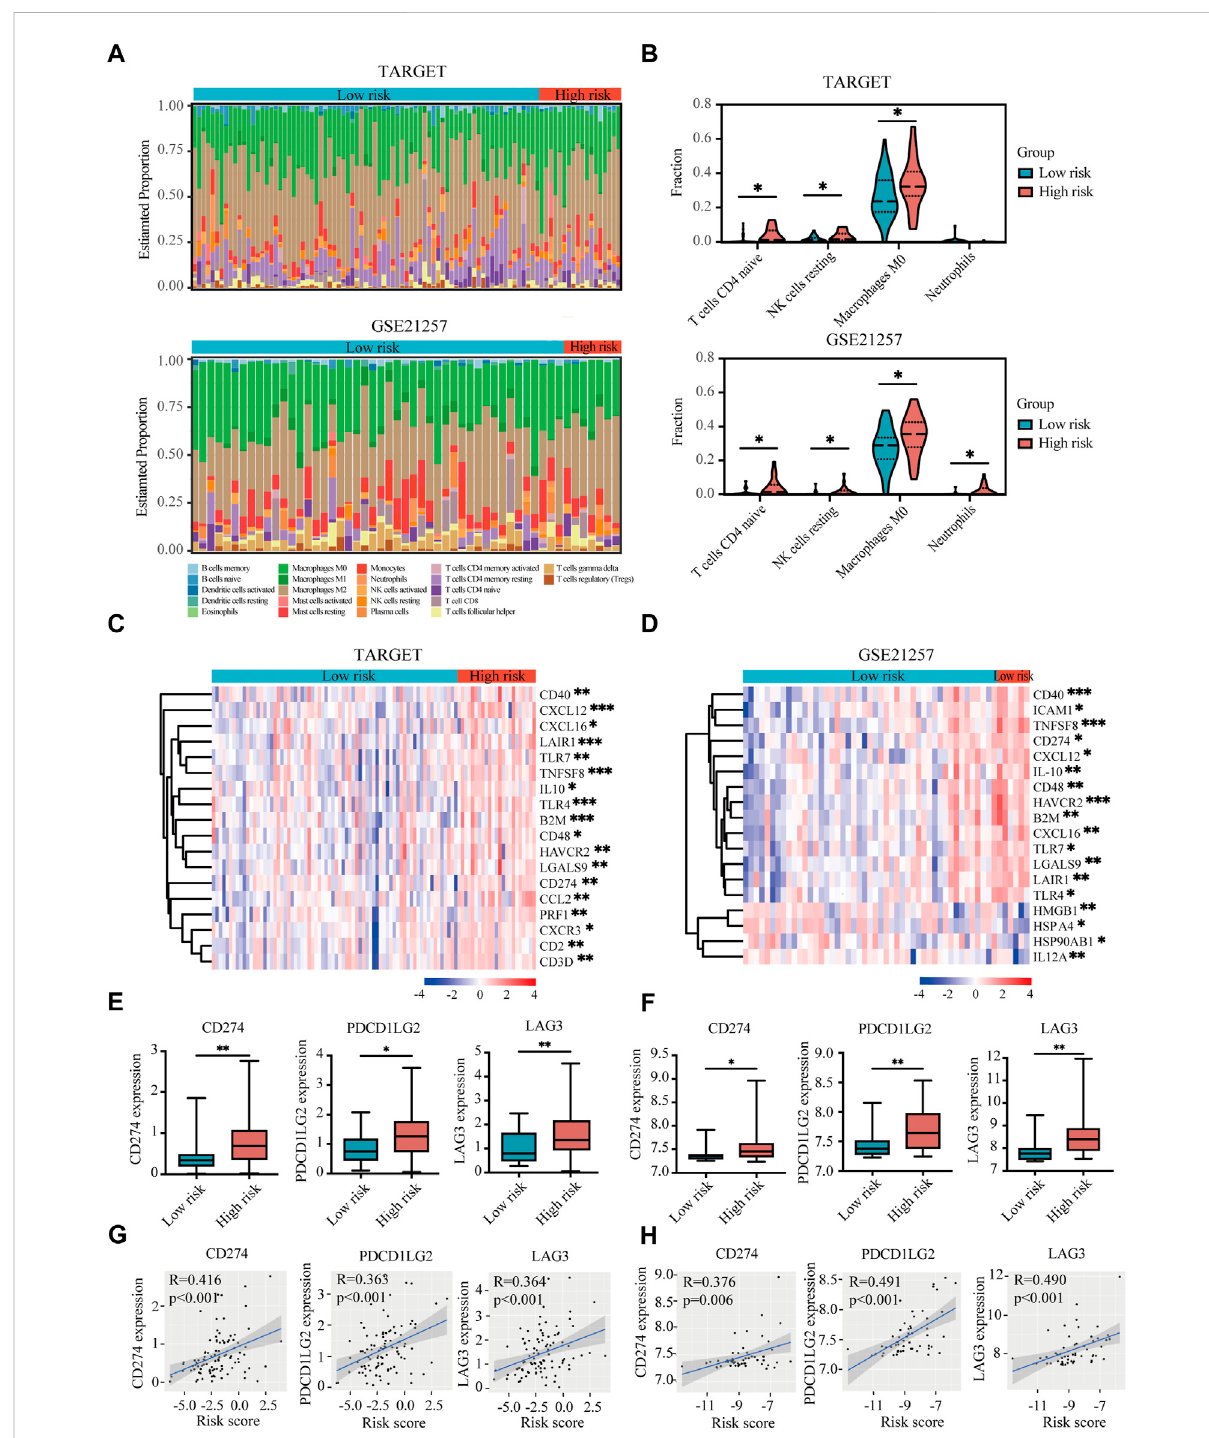
FIGURE 7 Immune landscape and immunosuppressive microenvironment between high-risk and low-risk groups of osteosarcoma patients. (A) Relative proportion of immune in fi ltration of 22 immune cells in the high-risk and low-risk groups in the TARGET and GSE21257 datasets. (B) Violin plots showingthesigni fi cantlydifferencesofimmunecellsbetweenhigh-riskandlow-riskgroupsintheTARGETandGSE21257datasets. (C,D) Heatmaps of the immunosuppressive genes in the high-risk and low-risk groups in the TARGET (C) and GSE21257 datasets (D) . (E,F) Expressions of three immune checkpoint genes (CD274), PDCD1LG2, and LAG-3) in high-risk and low-risk groups in the TARGET (E) and GSE21257 datasets (F) . (G,H) Correlation between expressions of immune checkpoint genes and risk score in the TARGET (G) and GSE21257 datasets (H) . * p < 0.05, ** p < 0.01, *** p <